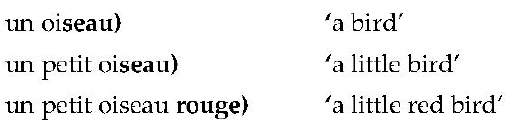
Figure 4. French phrase-final prominence in a complex sentence.